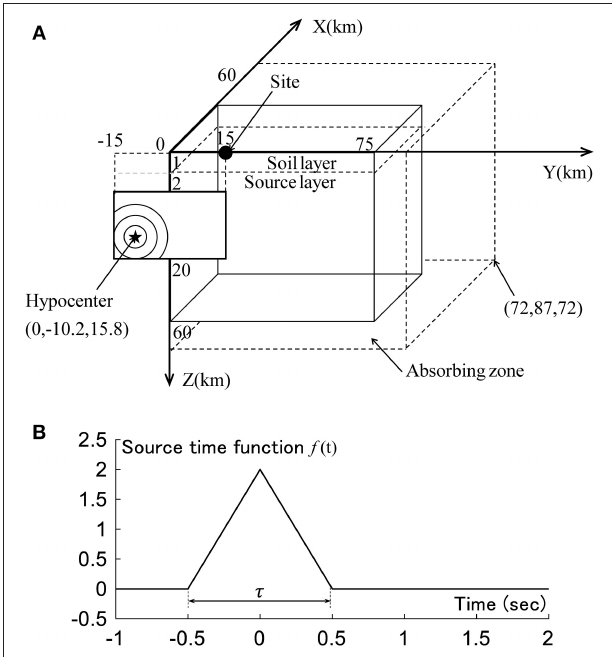
FIGURE 4 | Modeling of ground and fault. (A) Quarter grid model of FDM. (B) Source time function.